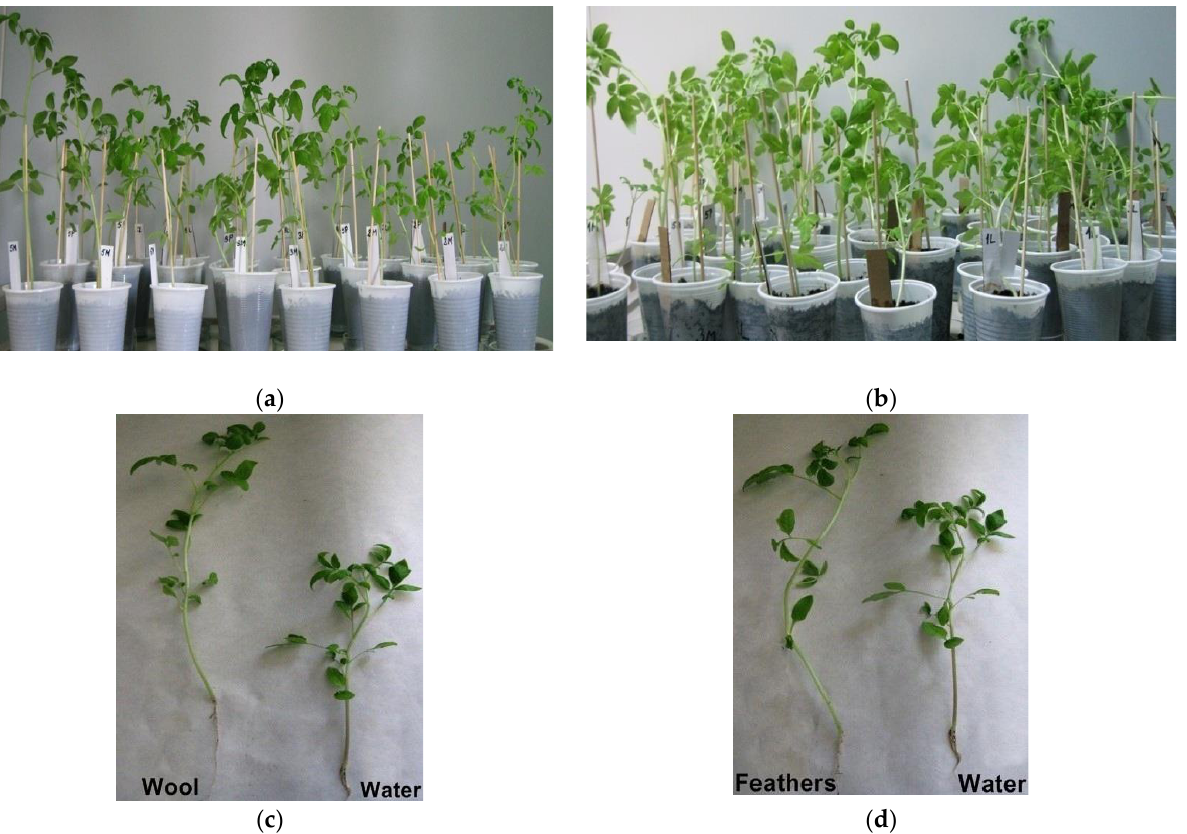
Figure 6. Aspects of plants treated with protein hydrolyzates from Paecilomyces lilacinus 112 in growth chamber conditions. ( a ) Tomato plants after four treatments with PH; ( b ) tomato plants one week after the end of treatment with PH; ( c ) tomato plants treated with PH from fungal culture on wool medium; ( d ) tomato plants treated with PH from fungal culture on feather medium.